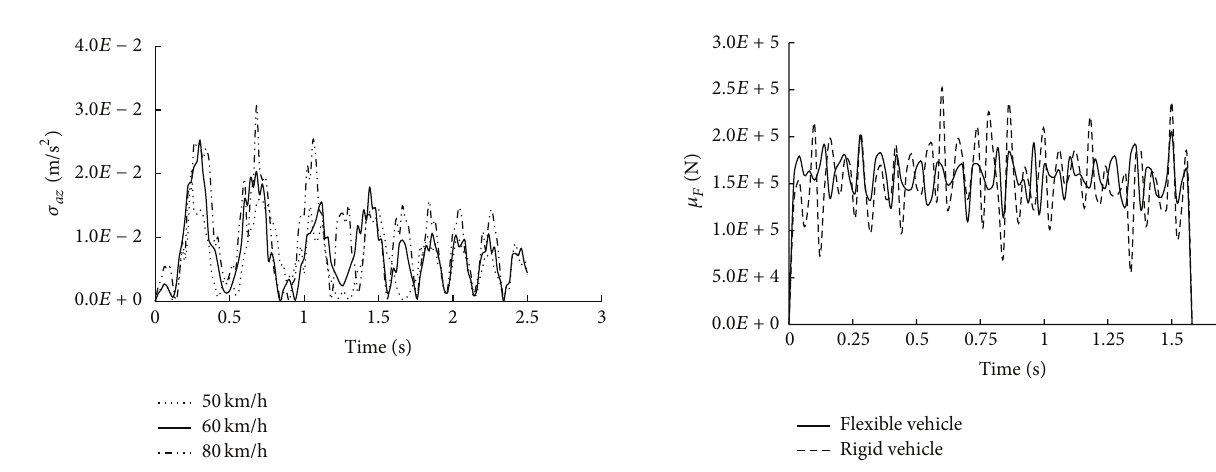
Figure 17: Standard deviation of vehicle acceleration at C.G.